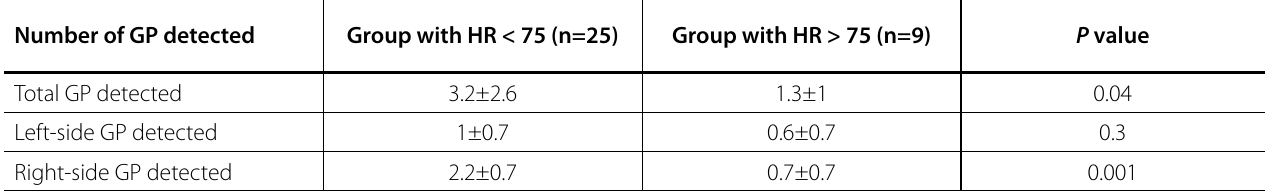
Table 4. Comparison of the average number of GP detected in relation to preoperative heart rate in the entire study